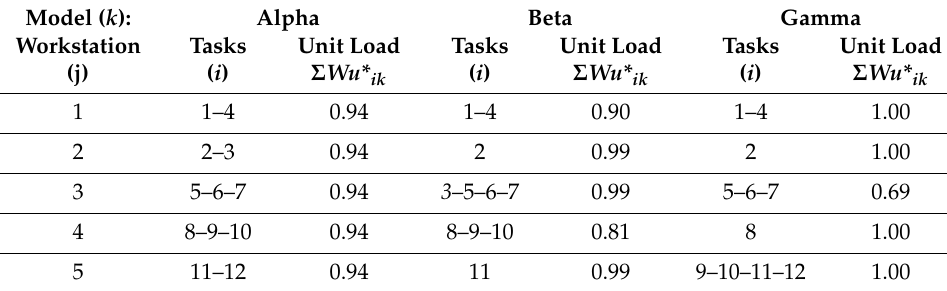
Table 9. Assignment of tasks to